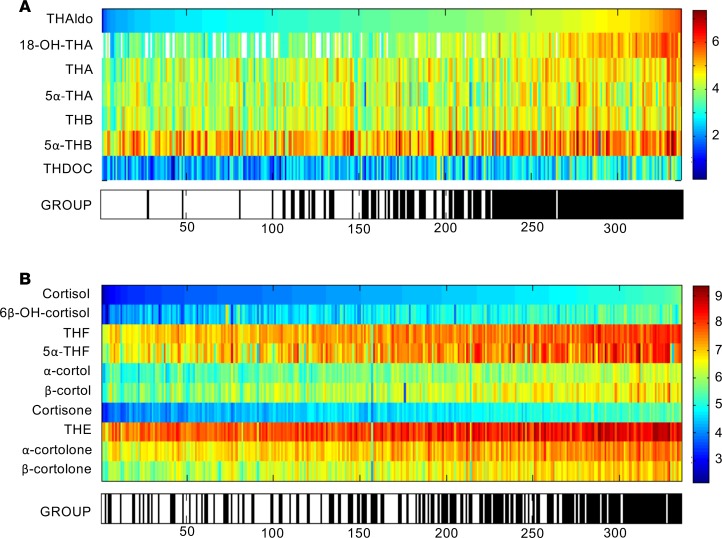
Heatmap visualizations of steroid metabolome profiling results in 174 primary aldosteronism patients.Steroid metabolite excretion in 24-hour urine was measured by gas chromatography-mass spectrometry in selected-ion-monitoring mode. Heatmap visualizations depict log-transformed steroid metabolite excretion values in the primary aldosteronism patients (group: black) in comparison to 162 healthy controls (group: white). (A) Mineralocorticoid and mineralocorticoid precursor metabolites ordered according to increasing amounts of tetrahydroaldosterone (THAldo) excretion. (B) Glucocorticoid metabolites in order of increasing amounts of cortisol excretion. Scale and color code were chosen separately for each panel according to the respective range of observed values. THA, tetrahydro-11-dehydrocorticosterone; THB, tetrahydrocorticosterone; THDOC, tetrahydro-11-deoxycorticosterone; THF, tetrahydrocortisol; THE, tetrahydrocortisone.